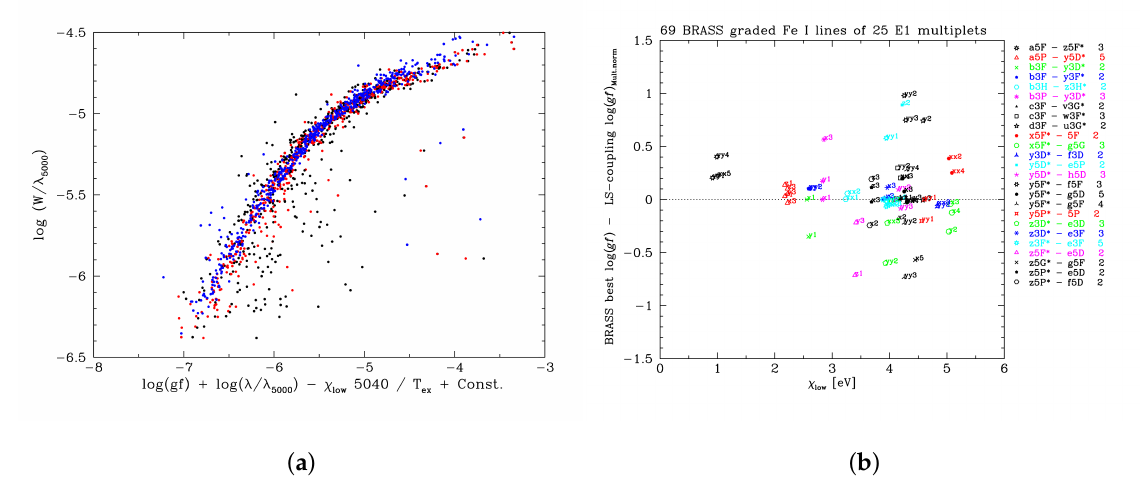
Figure 6. ( a ) The left-hand panel shows the curve-of-growth of Fe I lines investigated for BRASS. Substantial scatter observed in medium-strong and weak lines using literature log( gf )-values (black dots) is properly removed by replacing them with the values of the linear approximation method (red dots) or the GRID log( gf )-values (blue dots). ( b ) The right-hand panel shows the increase in ∆ log( gf )-values (BRASS-LS) against E low for lines of 25 multiplets (also marked to the right for the number of lines) having literature retrieved log( gf )-values of lesser quality in case E low > 4